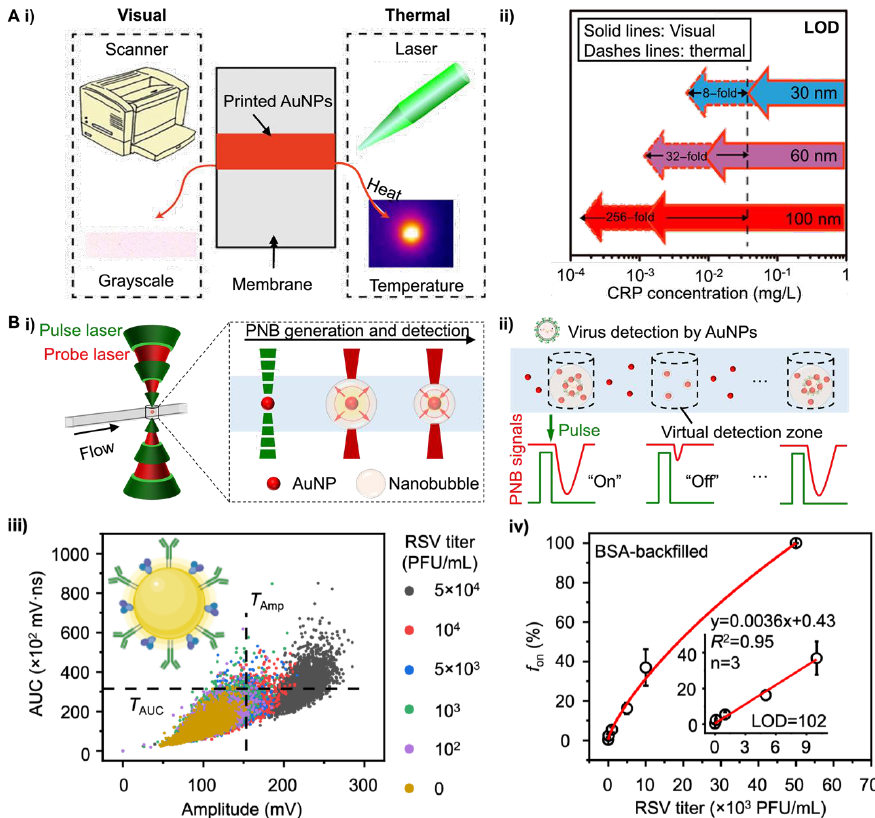
Figure 5. Photothermally active NM NPs for POC tests. ( A ) Thermal contrast amplification for Au NPs-based LFA: (i) schematic showing the visual and thermal detection of printed Au NPs on LFA membrane; (ii) comparison of the visual and thermal detection sensitivities in the diagnosis of C- reactive protein (CRP) using printed Au NPs of different sizes (e.g., 30, 60, and 100 nm). Adapted with permission from ref [66]. Copyright 2017 American Chemical Society. ( B ) Digital plasmonic nanobubble (PNB) detection for POC diagnosis of RSV: (i) schematic illustration of PNB generation mechanism; (ii) compartment-free digital plasmonic counting principle for virus detection; (iii) bi- variate scatter plots of amplitude and area under the curves (AUC) extracted from 3000 PNB signals for RSV detection; inset shows the model of antibody-functionalized Au NPs for the assay; (iv) the “f on ” counting results from (iii) against RSV with different concentrations. Adapted with permission from ref [67]. Copyright 2022 Springer Nature.